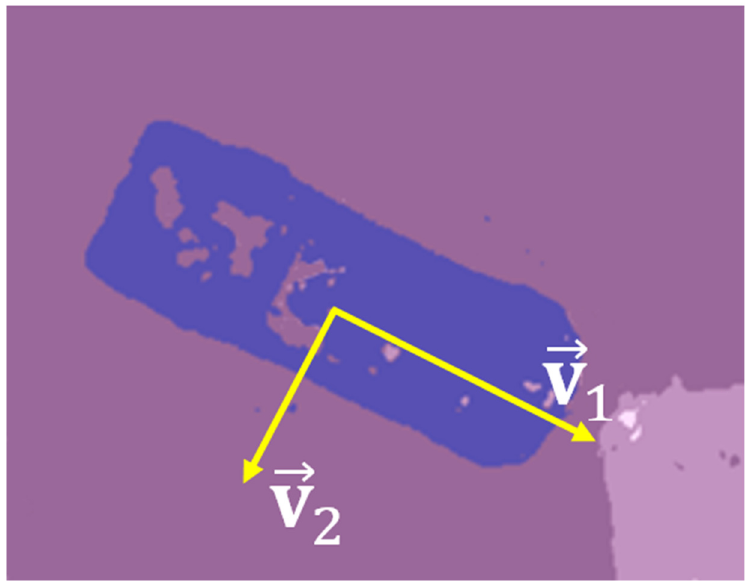
Figure 10. Segmented car. The car has an elongated shape and is rotated along axes 𝐯 𝟏 and 𝐯 𝟐 .